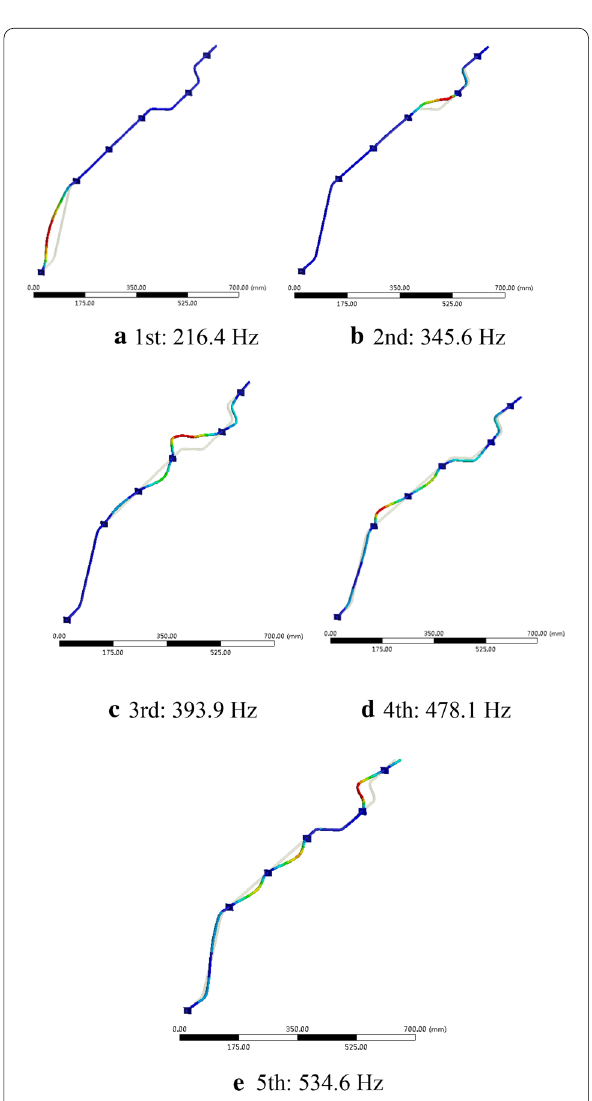
Figure 3 Vibration shapes for pipeline system. a 1st: 216.4 Hz. b 2nd: 345.6 Hz. c 3rd: 393.9 Hz. d 4th: 478.1 Hz. e 5th: 534.6 Hz